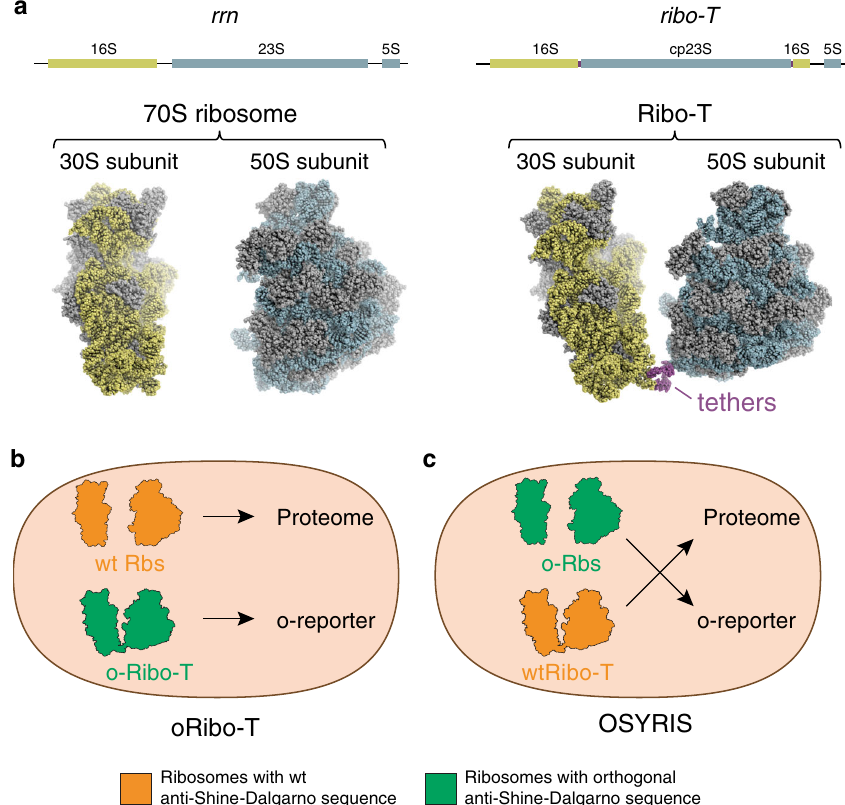
Fig. 1 The OSYRIS set-up. a Organization of rRNA genes and structure of the dissociable 70S ribosome (left) and Ribo-T (right). The small and large subunits of Ribo-T are covalently linked by two RNA tethers connecting circularly-permutated 23S rRNA to the loop of helix 44 in 16S rRNA 14,17 . The sequences of 16S rRNA sequences are shown in olive and those of 23S rRNA in gray. b In the original Ribo-T-based orthogonal translation system 14 , wt dissociable ribosomes translate the cellular proteome while the orthogonal Ribo-T (oRibo-T) is committed to the translation of the orthogonal reporter (o- reporter) mRNA. c In the OSYRIS cells (this work), the proteome is synthesized by Ribo-T whereas the dissociable ribosomes function as a specialized orthogonal translation system. The tethered nature of Ribo-T con fi nes both subunits of the dissociable ribosome (the 30S subunit with altered ASD and the 50S subunit) to the translation of only the o-reporter